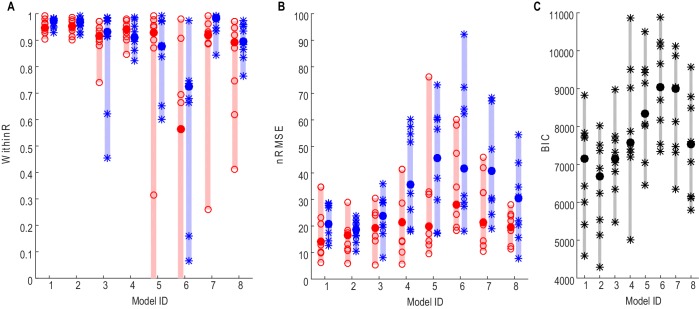
Force prediction performances of different models evaluated in terms of within-trial correlation (A), RMSE (B) and BIC (C).The filled dots and shaded bars show the median and range across all STNs; the open circles and stars show the data for each individual STN. The red dots and bars show performance in predicting high effort forces, while using data from low effort trials for model fitting; the blue dots and bars show performance in predicting low effort forces, while using data from high effort trials for model fitting. (C) The total BIC values combing the force predictions for low effort and high effort for all tested models. The filled dots and shaded bars show the median and range across all STNs; the stars show the data for each individual STN (some overlap). Models 1–3 use beta and gamma ERS as model inputs; Models 4–5 use activities from all three frequency bands (alpha, beta and gamma) as model inputs; Models 6–8 use activities from a single frequency band (alpha, beta and gamma, respectively) as model inputs.DOI:
http://dx.doi.org/10.7554/eLife.19089.00710.7554/eLife.19089.008Figure 2—source data 1.The excel data file related to Figures 2 and 6.It contains data about median WithinR and the normalized RMSE when different models were used for force prediction, as well as the average power modulations at the beta band and gamma band for each STN that was recorded in the main paradigm and used for the analysis.